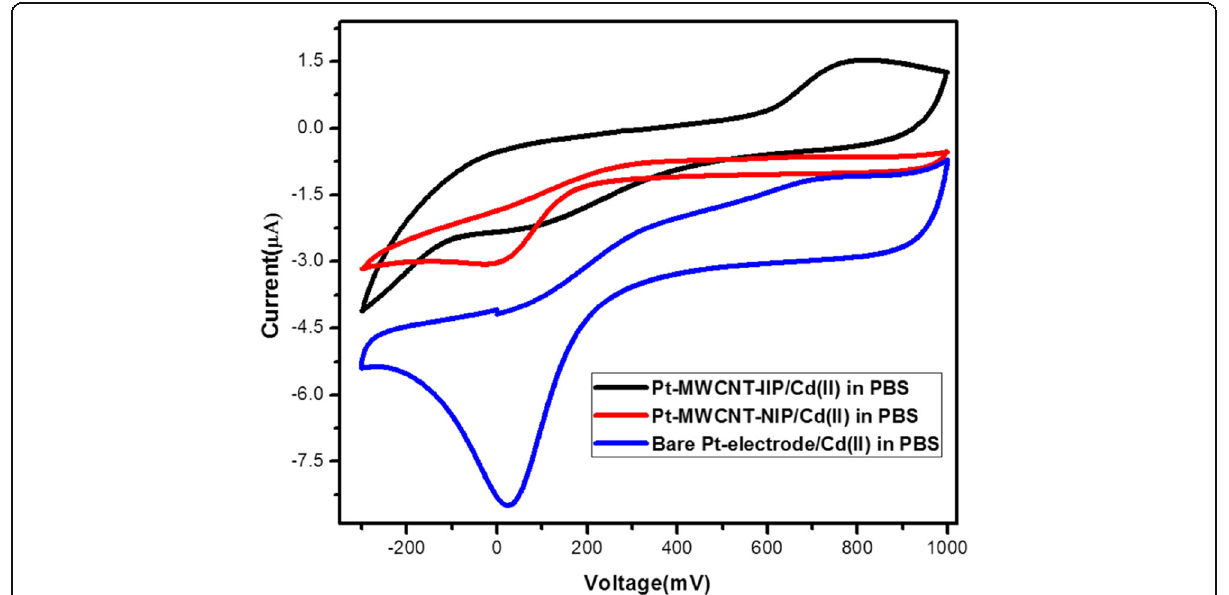
Fig. 7 Comparison of bare platinum electrode and modified platinum in the presence of Cd(II)